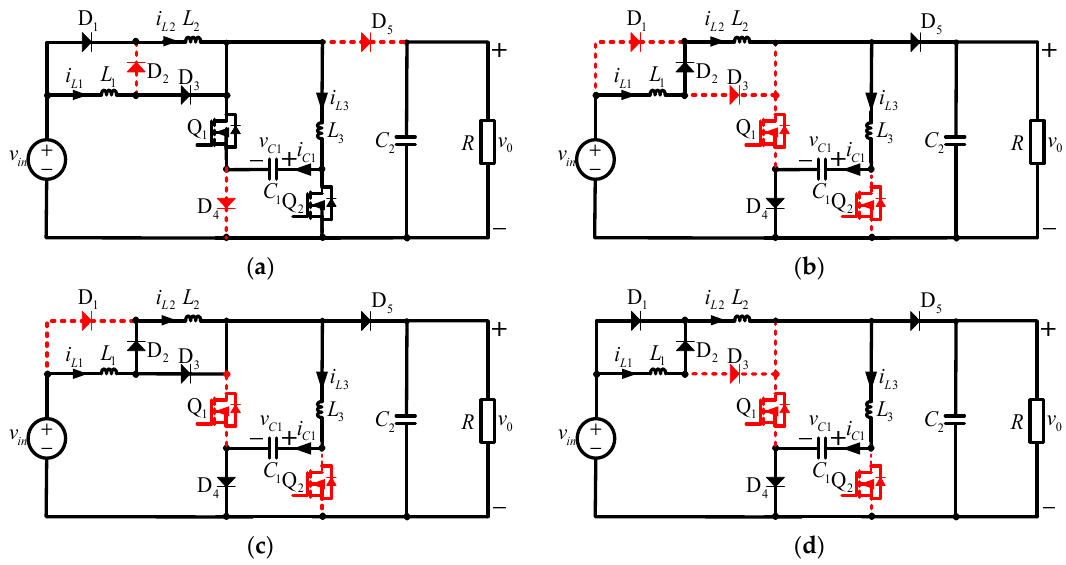
Figure 2. Equivalent circuits for possible stages of the proposed step-up converter in CCM. ( a ) Stage 1; ( b ) Stage 2; ( c ) Stage 3; ( d ) Stage 4.